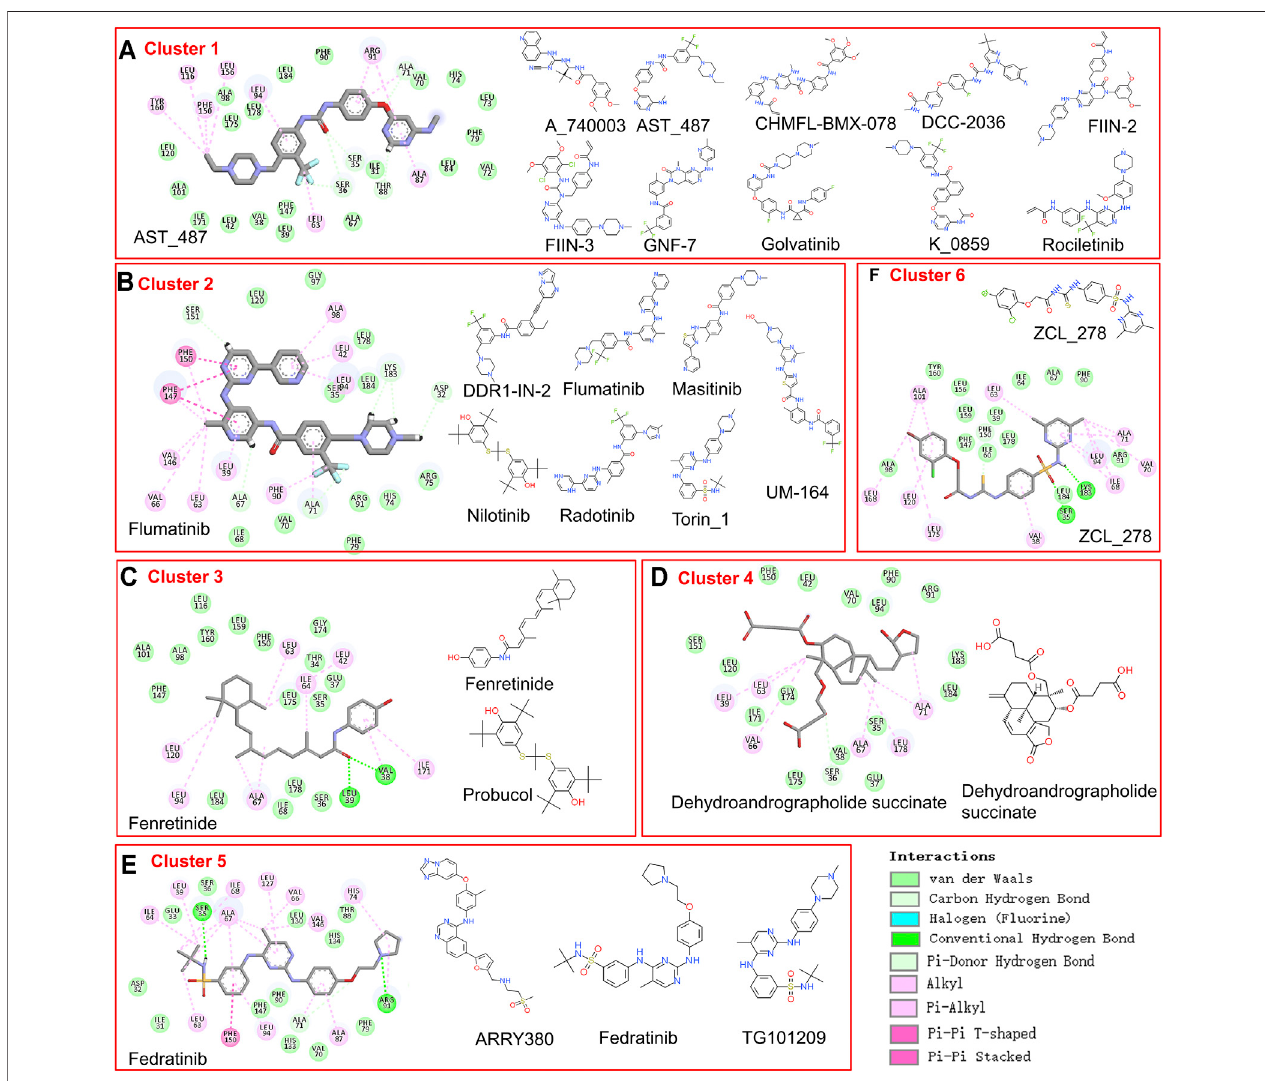
FIGURE 4 | The compounds in six clusters of list 2 and the 2D interaction of each representative compound with the binding pocket.